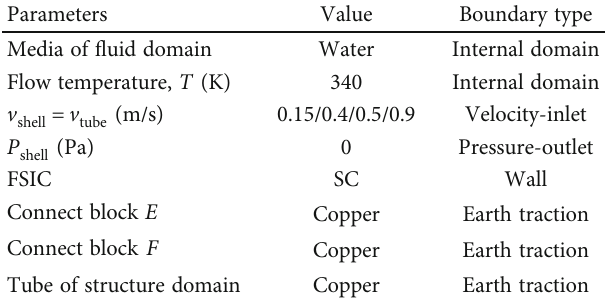
Table 2: Boundary type and parameters of the simulation.